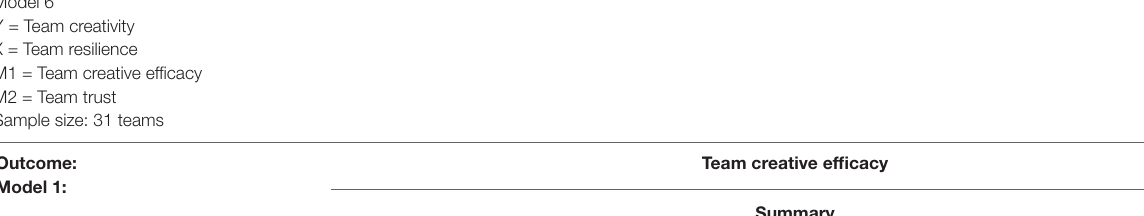
TABLE 3 | Results of sequential mediation analyses (PROCESS Model 6 in SPSS). Model 6 Y = Team